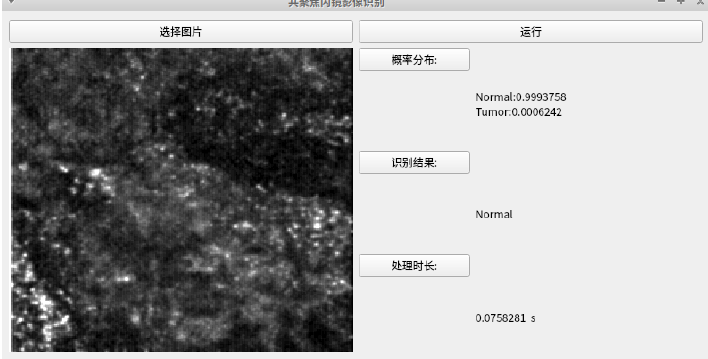
Fig. 4. Display of negative sample test results.